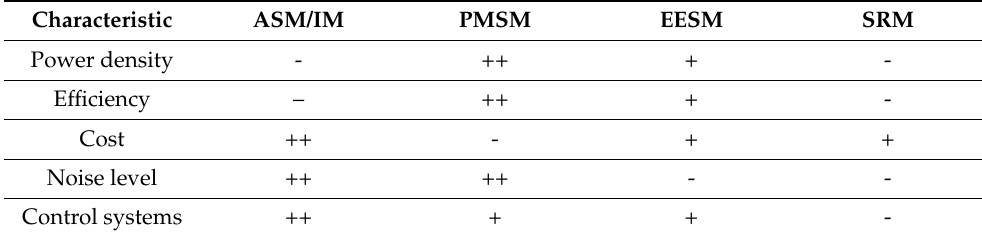
Table 1. Rating of different e-machine types